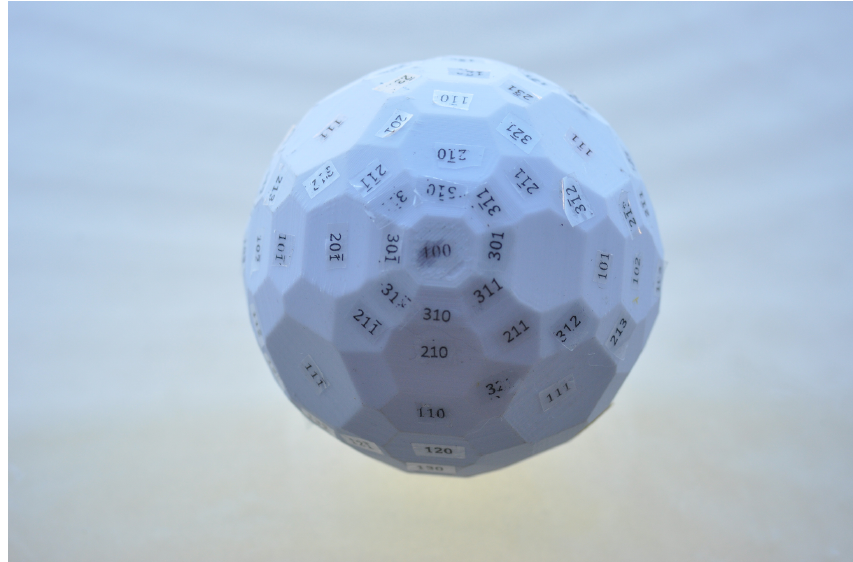
Figure 10. Copy made by 3D printing from the digital model. Diameter 65mm.